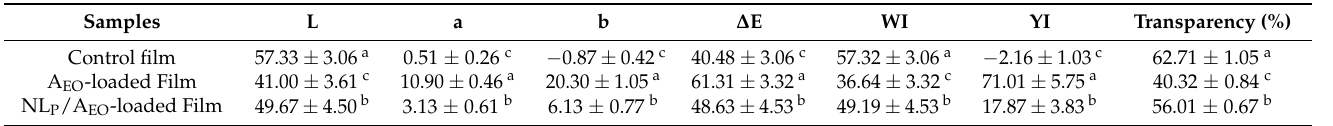
Table 2. Effect of free and nanoliposomal A EO color properties of Salep mucilage bionanocompos- ite films.